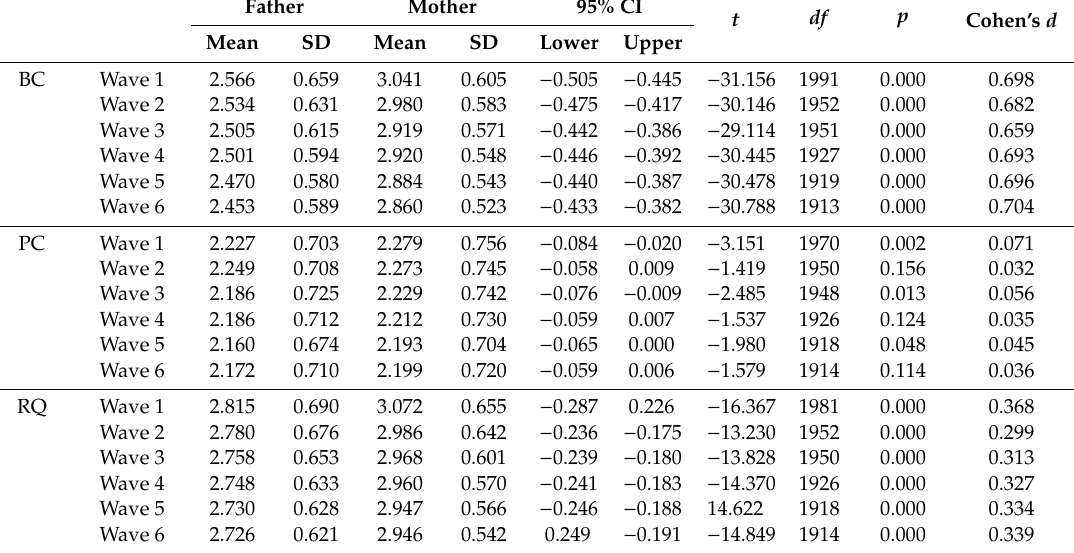
Table 7. Descriptive statistics and paired t-test results for parent-child subsystem qualities between fathers and